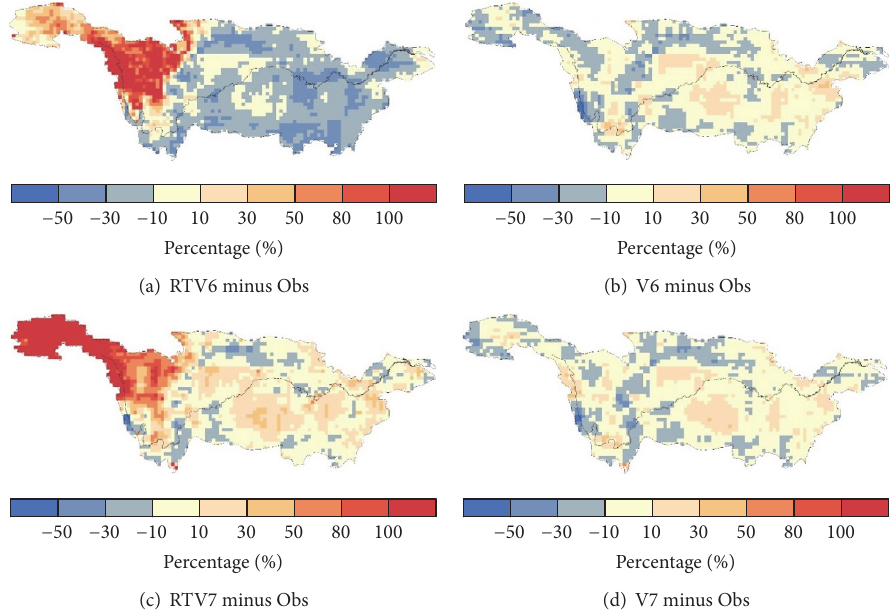
Figure 3: The relative bias of the TMPA precipitation estimates against the interpolated observed precipitation data for the average annual precipitation in the Yangtze River